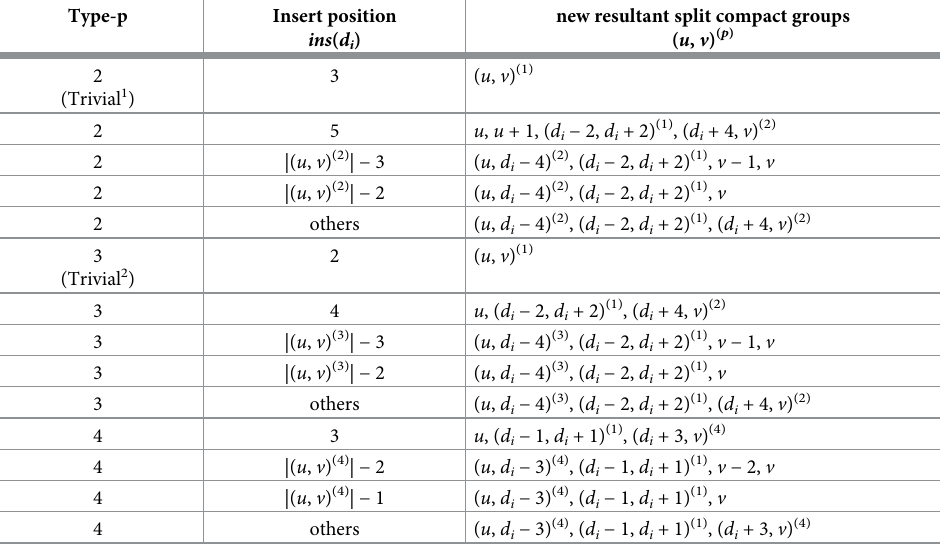
Table 2. Summary of insertion position and the sequence of insertion in forms of split compact groups. Type-p Insert